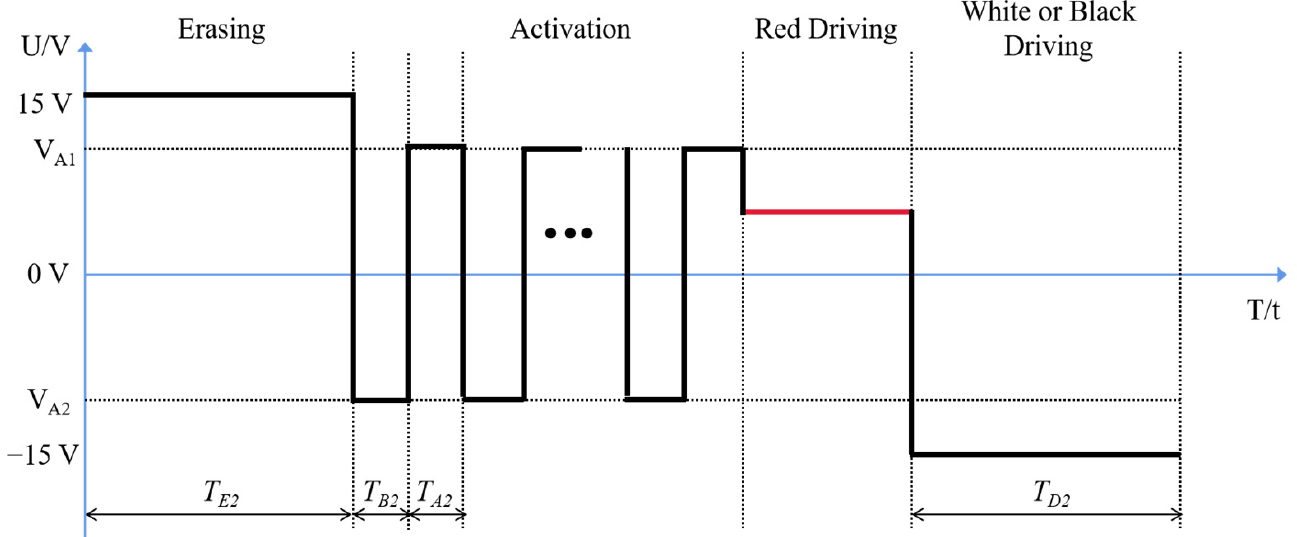
is the duration of negative voltage (cid:3003)(cid:2870) is the duration of the (cid:3005)(cid:2870) is the negative voltage of (cid:3002)(cid:2870)